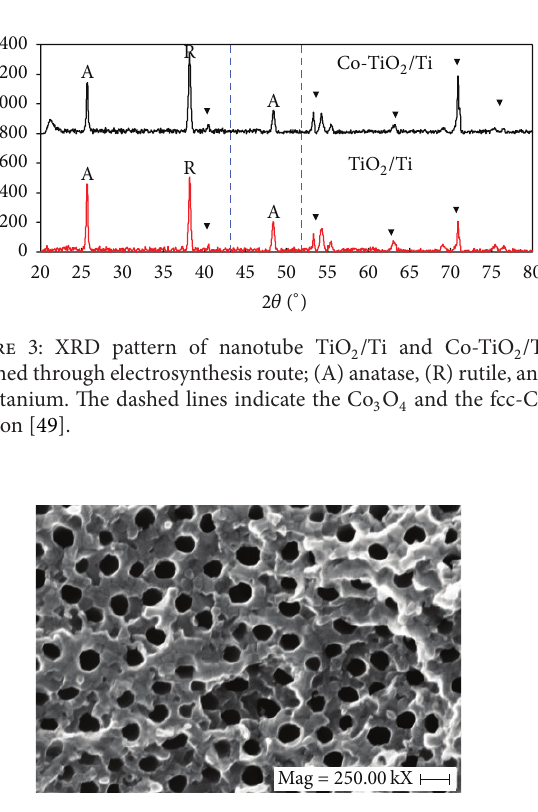
Figure 4: SEM top view of sample Co-TiO 2